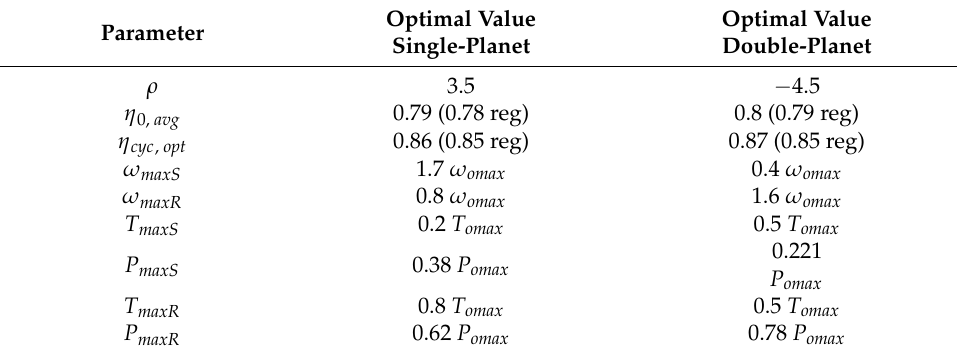
Table 2. Powertrain optimal